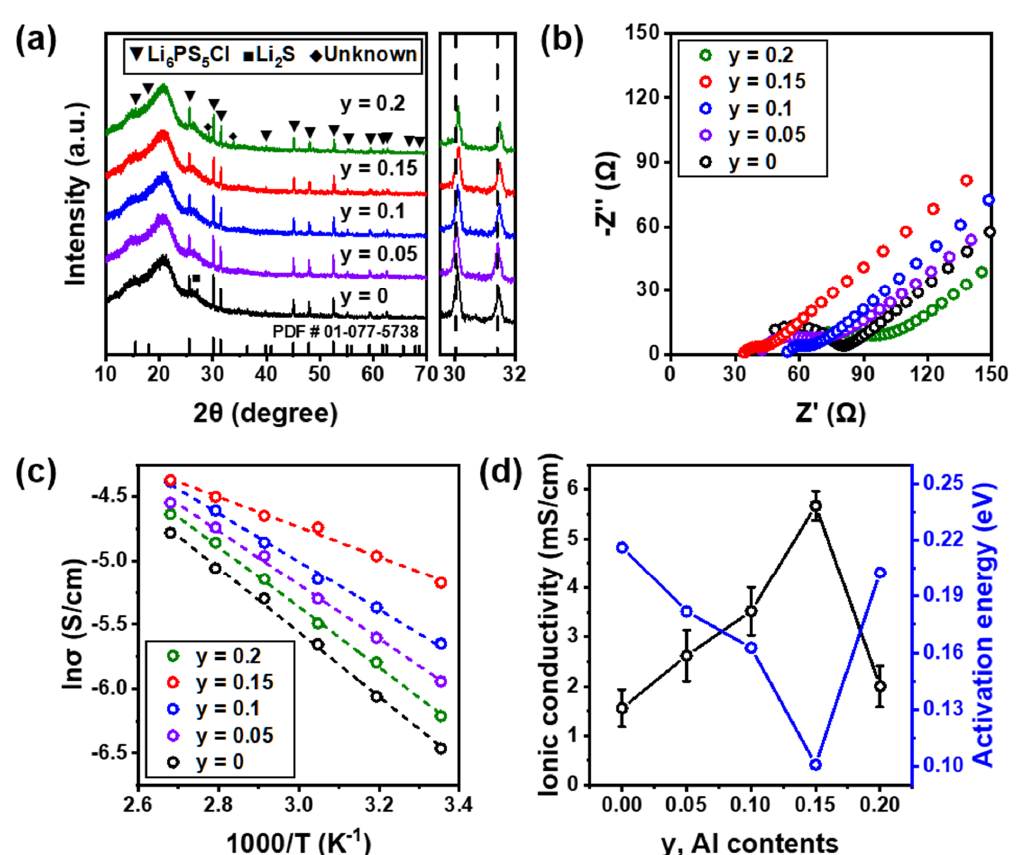
Figure 2. ( a ) XRD patterns of Li 6−3y Al y PS 5 Cl (0 ≤ y ≤ 0.2) electrolytes. ( b ) Nyquist plots of Li 6−3y A- l y PS 5 Cl (0 ≤ y ≤ 0.2) electrolytes measured at 25 °C. ( c ) Arrhenius plots of Li 6−3y Al y PS 5 Cl (0 ≤ y ≤ 0.2) electrolytes measured in the range of 25 to 100 °C. ( d ) E a and ionic conductivity of Li 6−3y Al y PS 5 Cl (0 ≤ y ≤ 0.2) electrolytes as a function of the Al